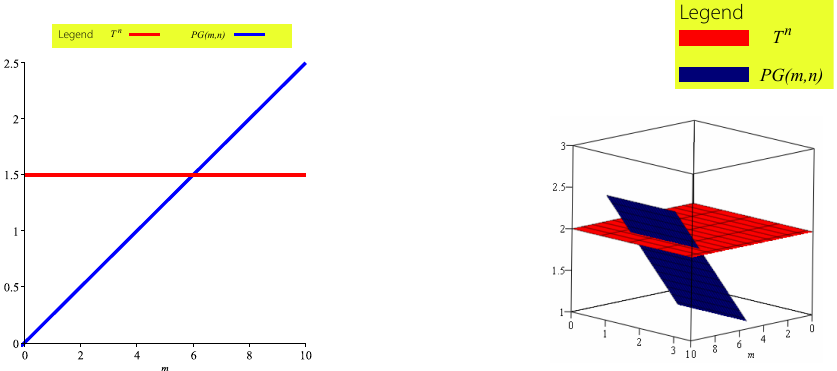
Figure 4. 2D Graphical Comparison ( Left ) and 3D Graphical Comparison ( Right ) of fdim ( T n ) and fdim ( PG ( m , n ))